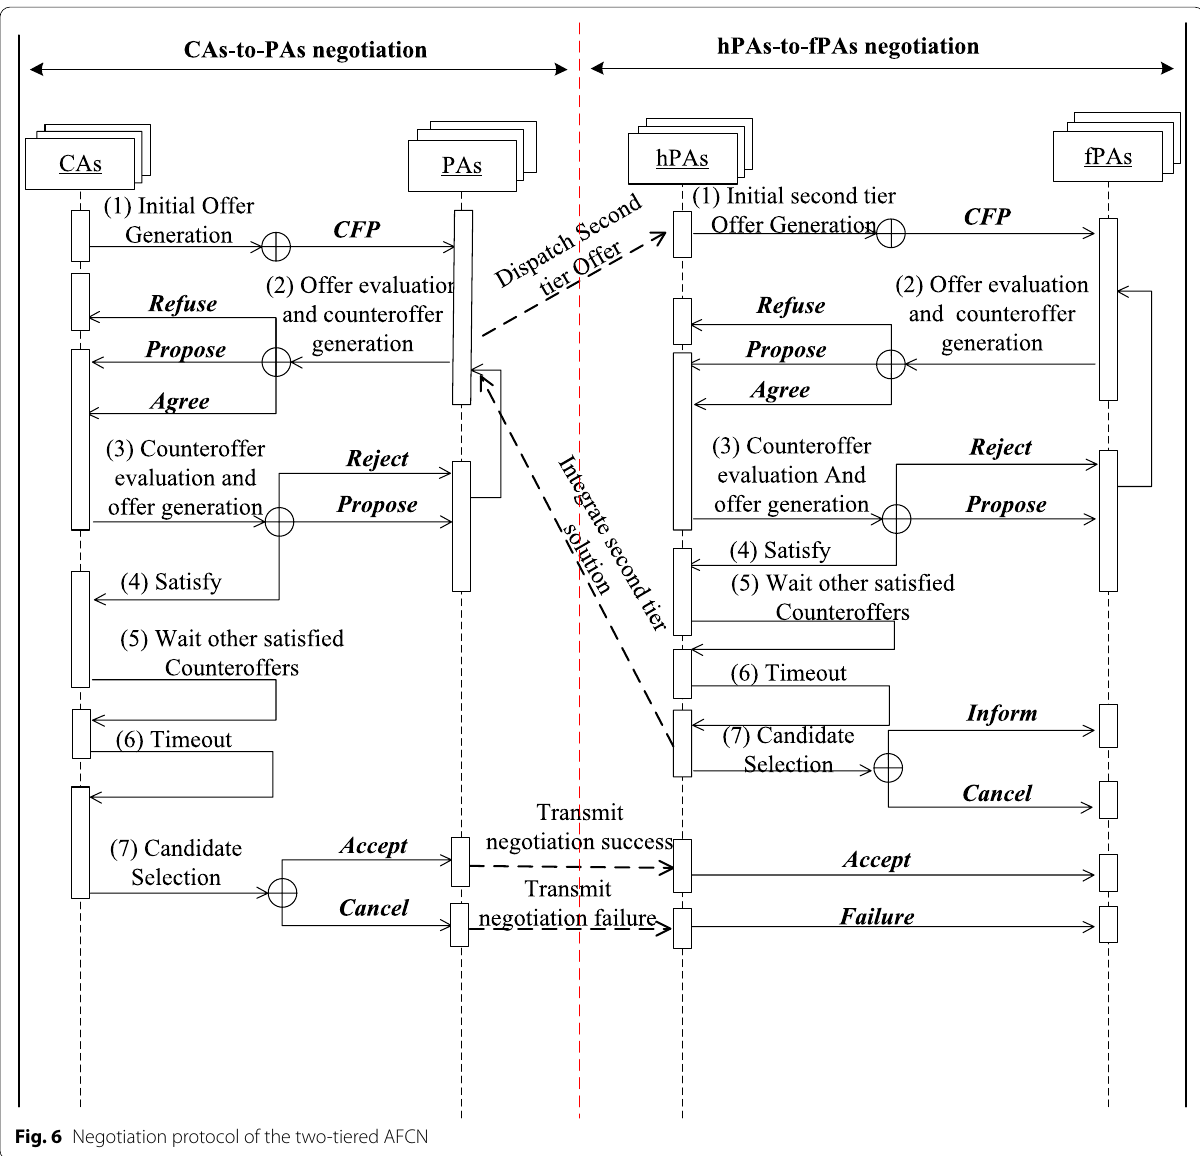
Fig. 6 Negotiation protocol of the two-tiered